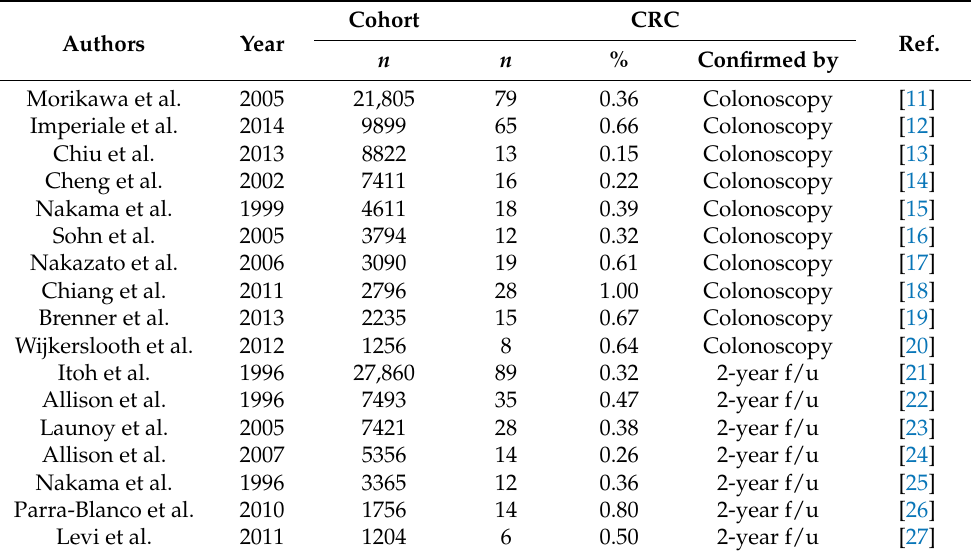
Table 1. Prevalence of CRC in average-risk adults reported in large-scale